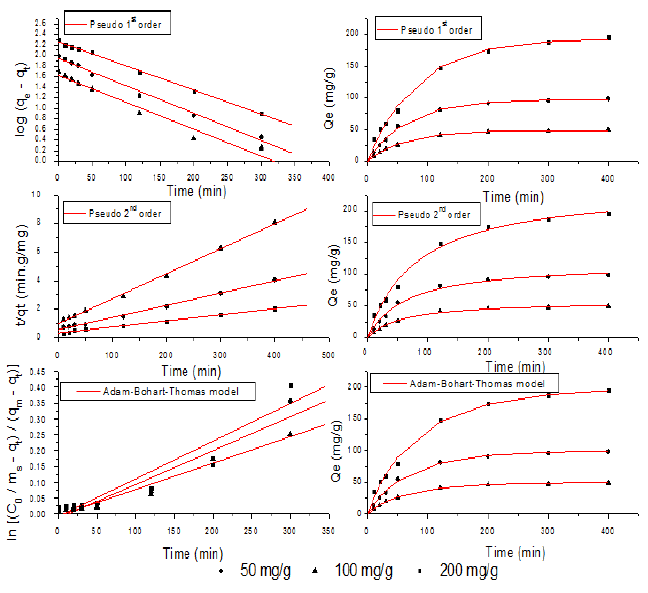
Figure 3. Sorption kinetic of copper on Brushite (DCPD) Right: Non-linear regression analysis Left: Linear regression